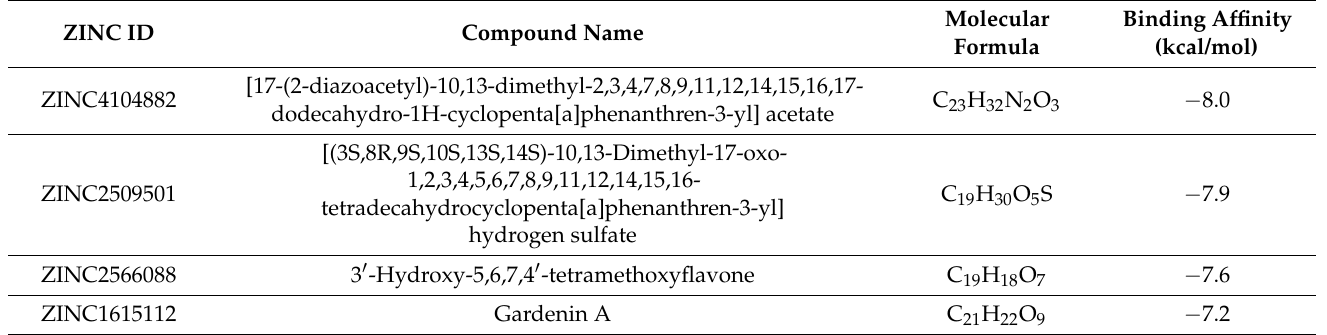
Table 1. List of the top four compounds and their chemical name, molecular formula, and binding affinity (kcal/mol) of the selected four compounds. The compounds were selected based on the binding affinity score obtained from the molecular docking